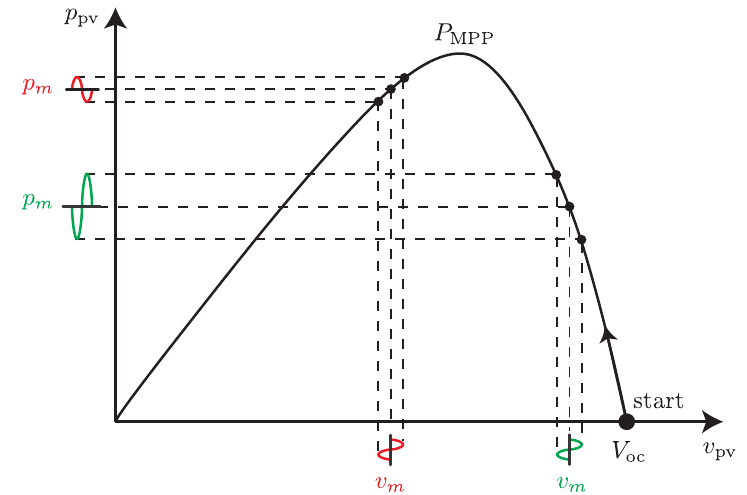
Figure 5. Detection of the PV panel operation: to the left of the MPP (red, with p m and v m in-phase) and to the right of the MPP (green, with p m and v m in